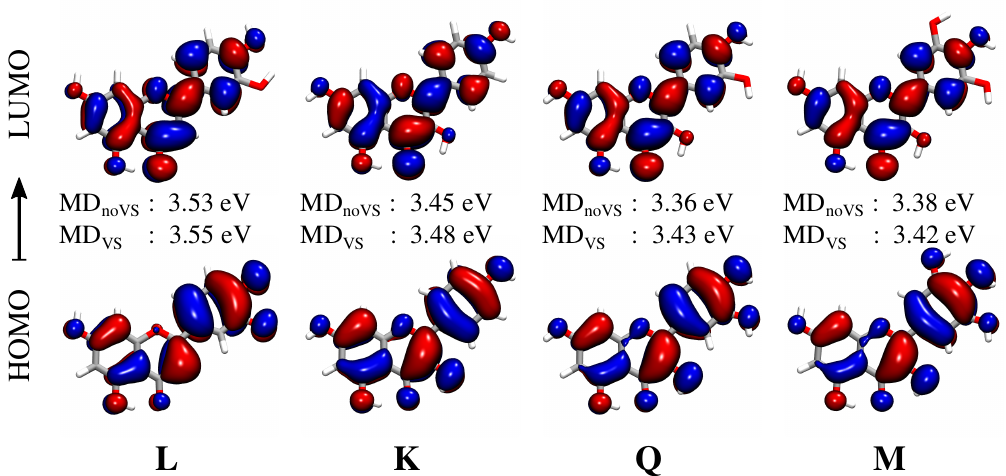
Figure 7. Molecular Orbitals (MOs) involved in the first electronic transition of each flavonoid. The corresponding excitation energies are also given for both MD VS and MD noVS . Isovalue: